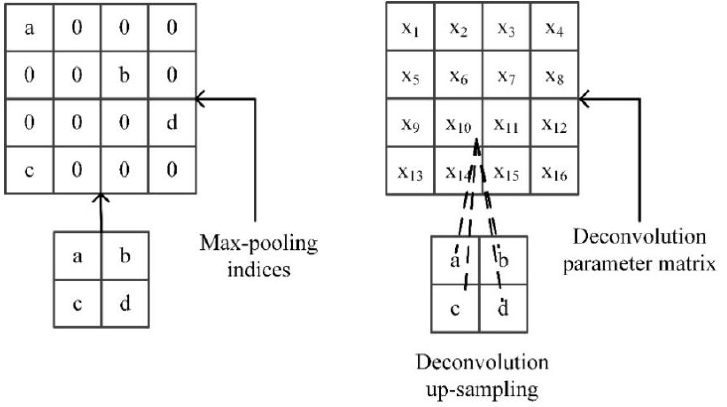
Figure 4. Max-pooling indices and deconvolution up-sampling.